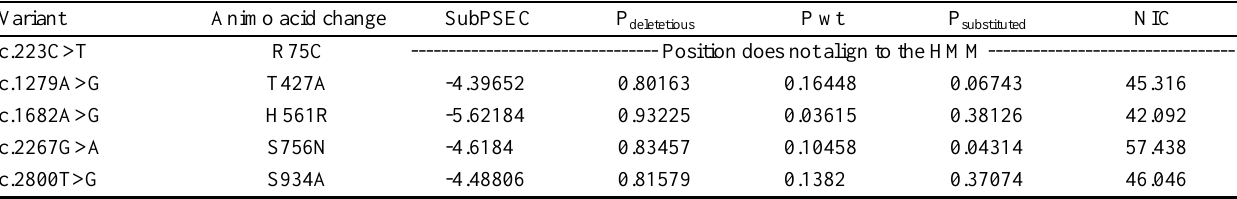
Table 3. Classification criteria for NSDD induced by fibre-deficient diet Group Symptom